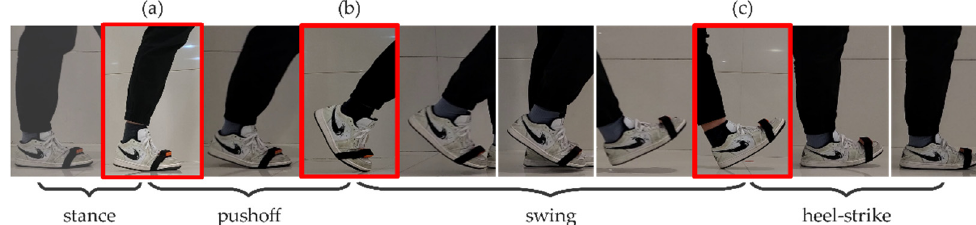
Figure 4. The movement of a whole stride can be divided into four gait phases. ( a ) displays that the heel just leaves the ground at the end of stance phase; ( b ) displays that the toe is going to leave the ground at the end of push-off phase; ( c ) displays that the heel touches the ground at the end of swing phase.